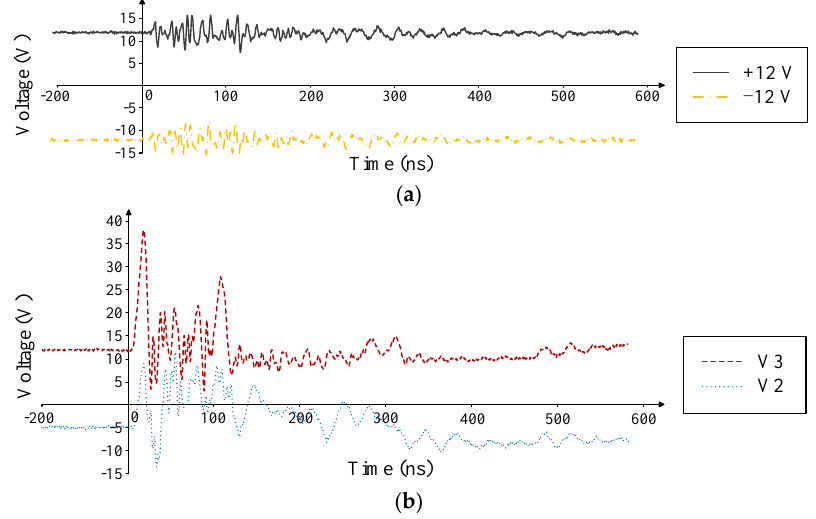
Figure 12. Transient interference at each measuring point when a 2 kV/100 kHz electrical fast transient burst was applied to the signal end of the acquisition card: ( a ) Transient interference between a ± 12 V supply level and AGND. ( b ) Transient interference between V2, V3, and AGND.